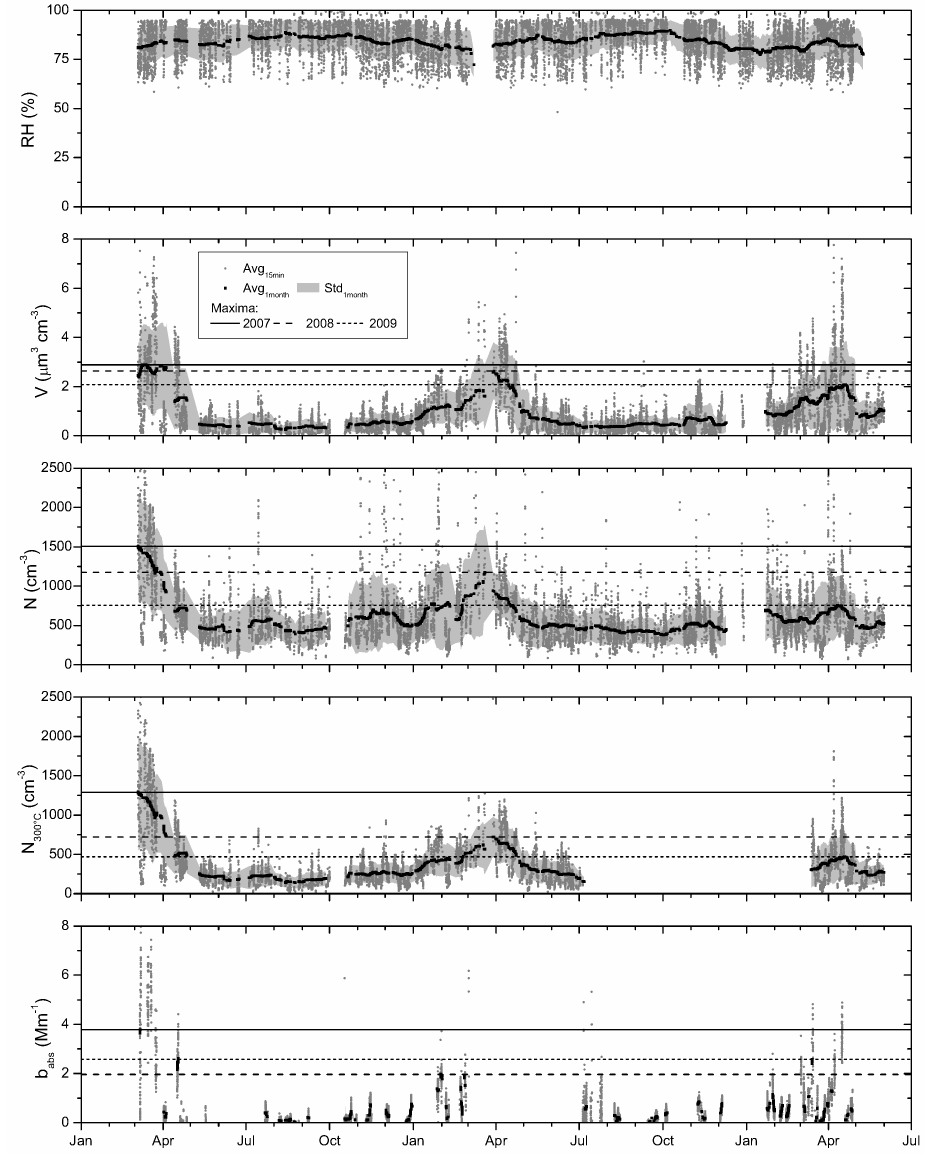
Fig. 3. Same as Fig. 2 but for data observed in the